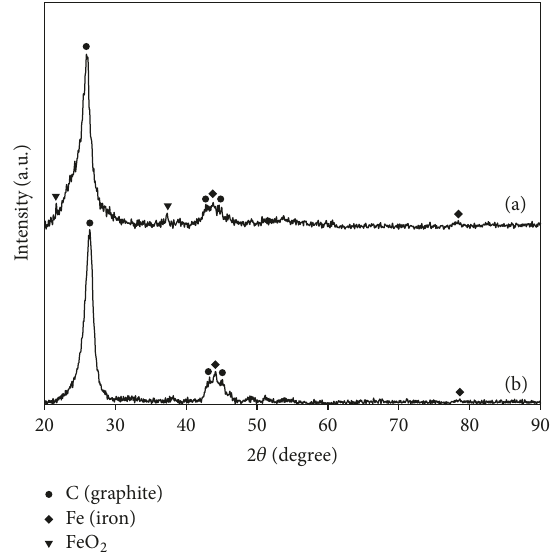
Figure 2: XRD patterns of the (a) as-synthesized CNTs and (b) after the acidic